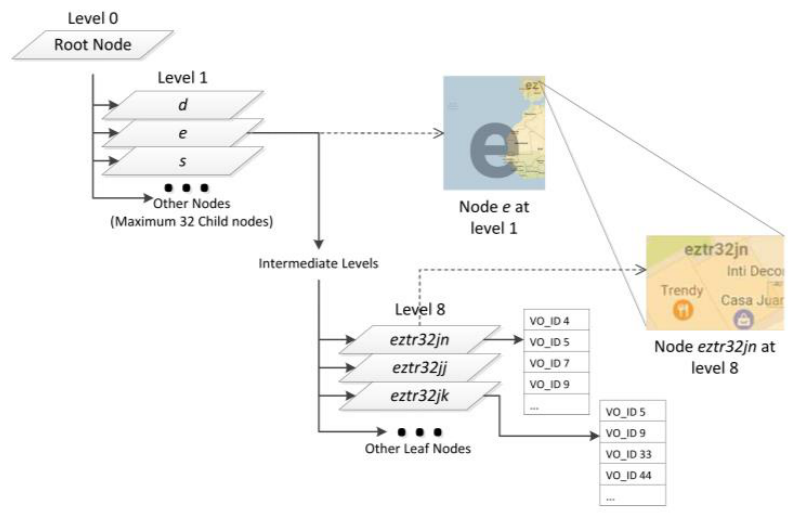
Figure 4. Geohash-Grid Tree Structure. Maps are generated by using the Geohash Explorer service [31].